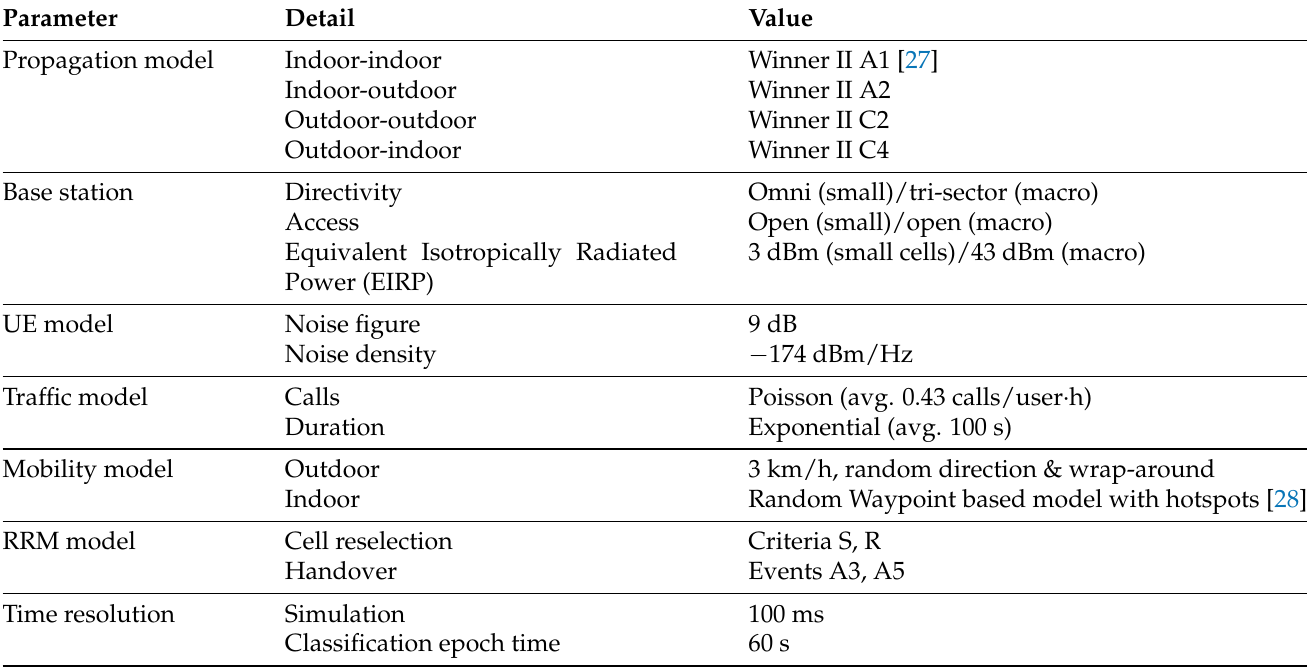
Table 1. System level simulator